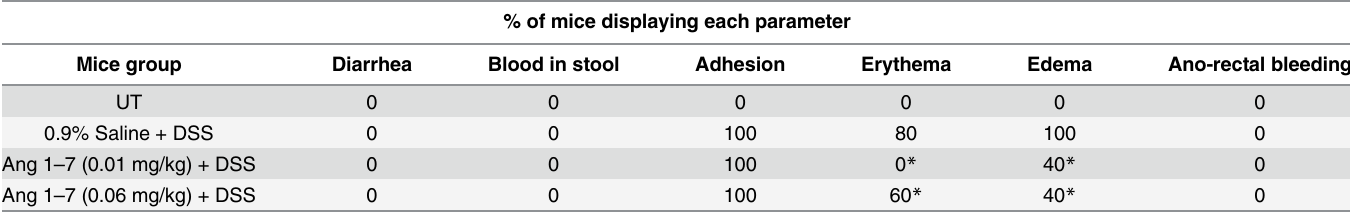
Colitis severity was assessed by macroscopic examination in UT mice and in mice treated for 3 days with i.p saline or Ang 1 – 7 post DSS treatment (for 4 days). Numbers are the means of 5 – 18 mice for each group (9 for UT, 18 for DSS/i.p saline and 5 for Ang 0.01 mg/kg and Ang 0.06 mg/kg). * denote signi fi cant difference from DSS/i.p saline treated